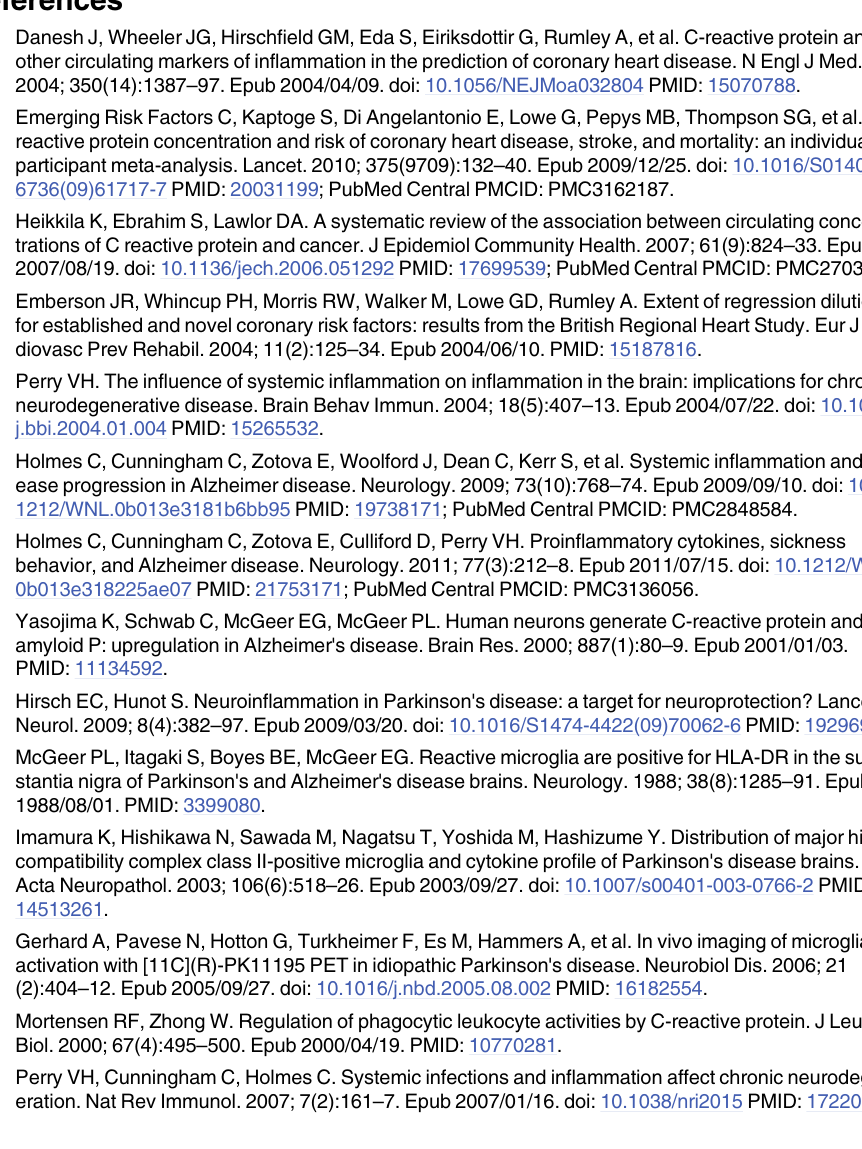
S4 Fig. Possible mechanism of subclinical systemic inflammation and neurodegeneration in PD. Subclinical systemic inflammation leads to an increase proinflammatory state, which elicits neuroinflammation and nitration of a-synuclein. This further causes microglia activa- tion, inflammasome formation, and mitochondrial damage. S1 Table. Baseline clinical features by life outcomes in Parkinson disease.